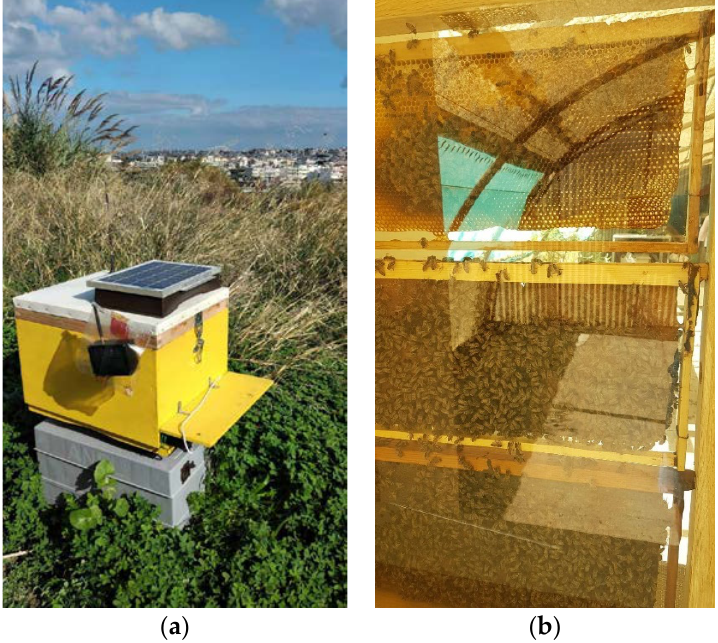
Figure 1. ( a ) beehives monitored in the course of this work with a number of sensors. The e-beehive in the field. ( b ) an observation beehive allows us to spot the queen and observe the patterns of activity inside it.